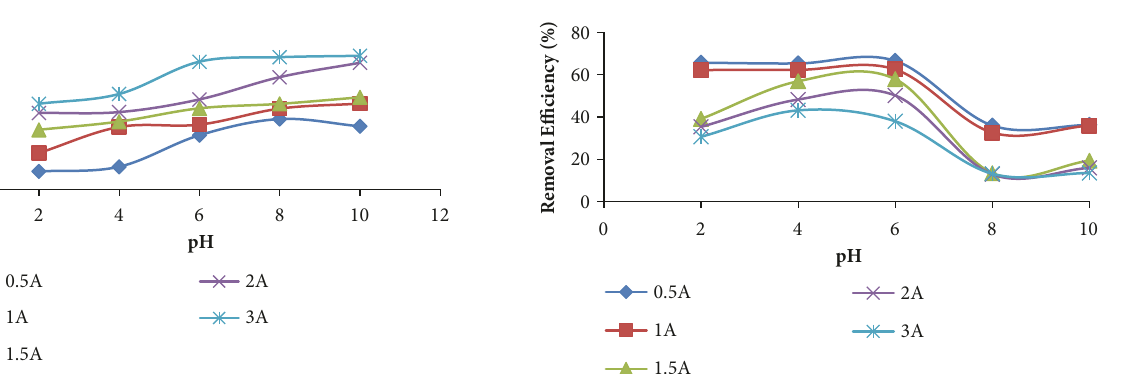
Figure 3: Effect of pH at varying current densities, for PW at 60 ∘